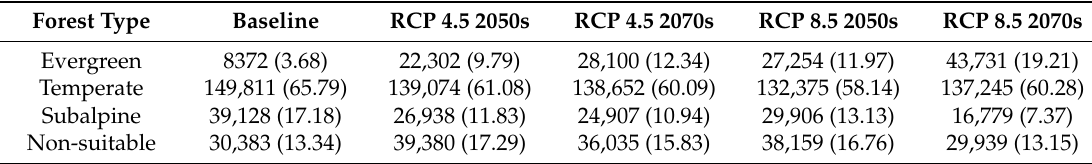
Table 1. Habitat suitable area statistics of each forest type and period, km 2 (%).